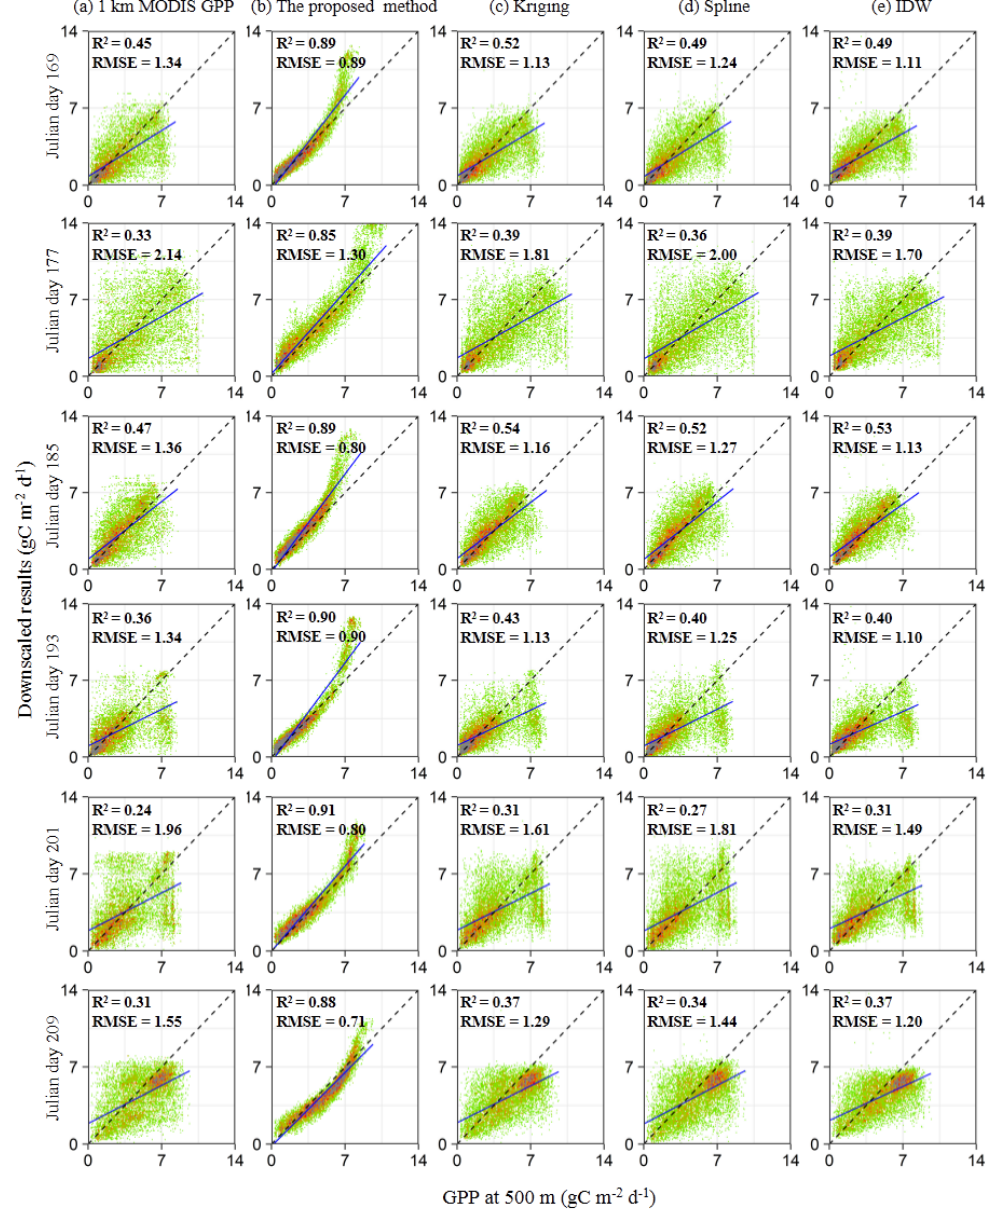
Figure 4. Density scatterplot between MODIS GPP and downscaled GPP at 500 m during Julian days 169–209. ( a ) represents the comparison between MODIS GPP products; and ( b – e ) represent the comparison between downscaled GPP and MODIS GPP at 500 m. The solid lines are the regression lines, while the dashed lines are the 1:1 lines. The green and red represent the low-density and high-density areas, respectively.